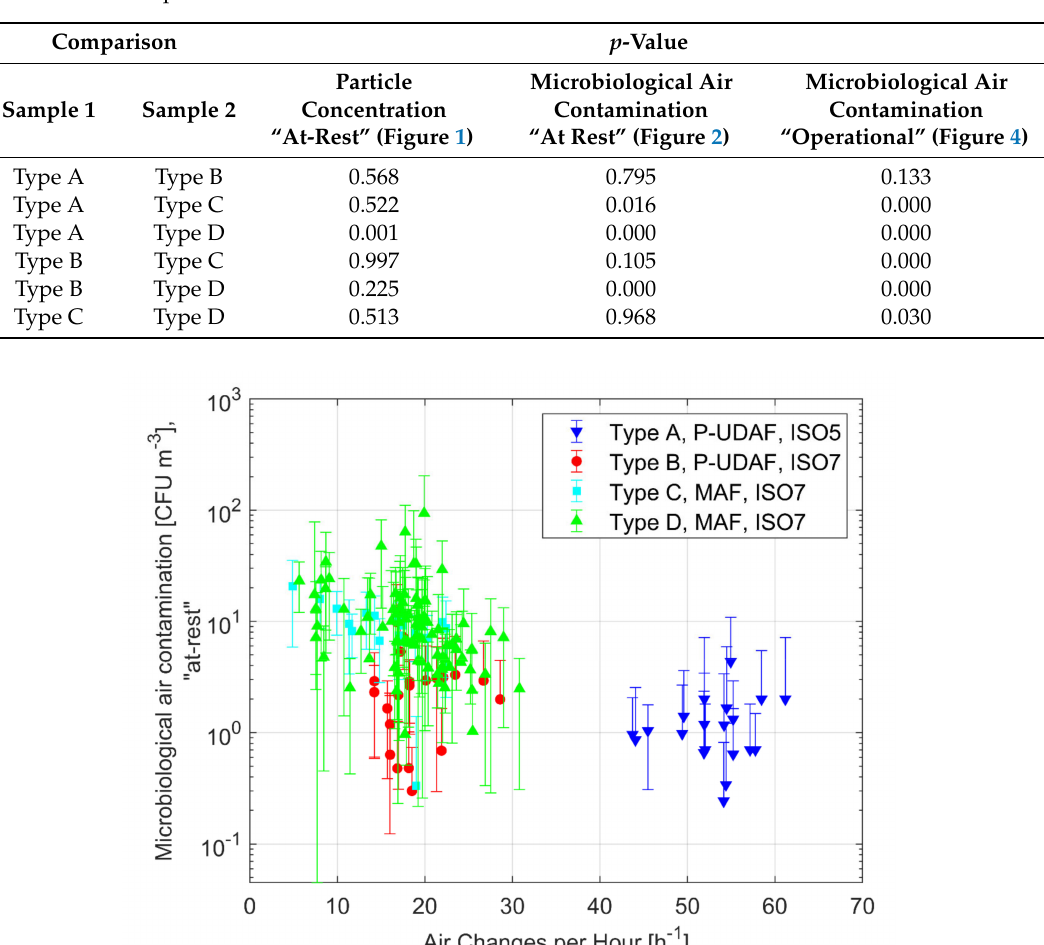
Figure 2. Average microbiological air contamination vs. air changes per hour (ACH) in “at-rest” conditions for the 175 investigated